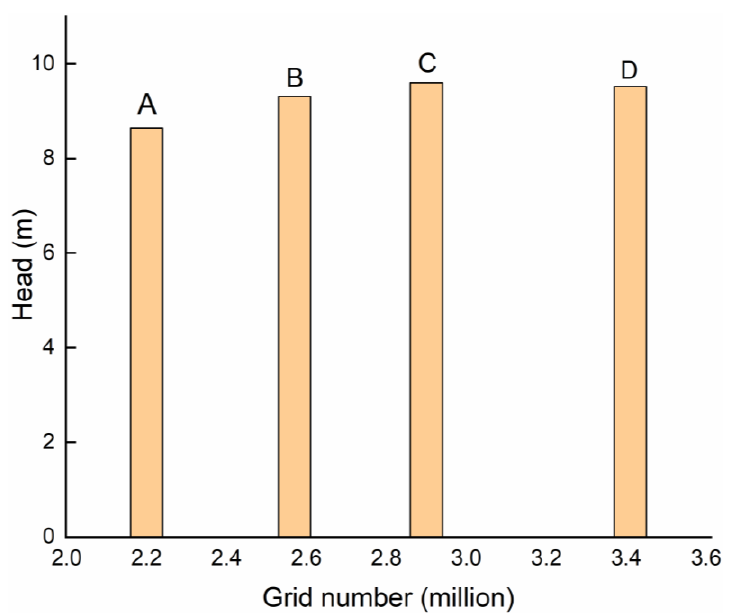
Figure 12. Grid-sensitivity analysis.